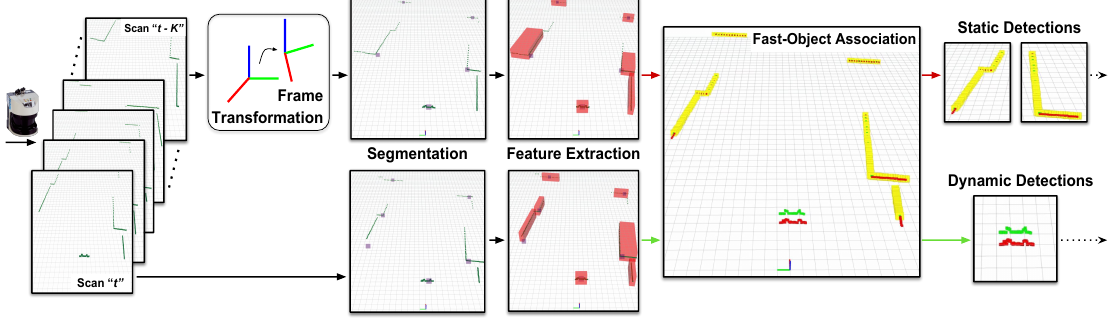
Figure 4. General schema for detecting moving objects with single-layer laser rangefinders (LRFs). We segment the laser measurements using a dynamic threshold and extract different geometric features from each cluster obtained. A fast-matching step is later performed between time-separated scans to filter out static objects, leaving to the next tracking step only the elements of the scene considered as dynamic. Thus, we can reduce between two and five times the objects arriving to the